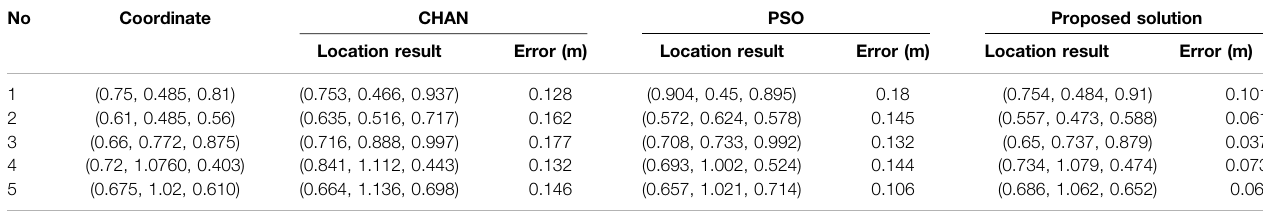
TABLE 2 | Performance comparison of Pd location algorithm in power transformer of